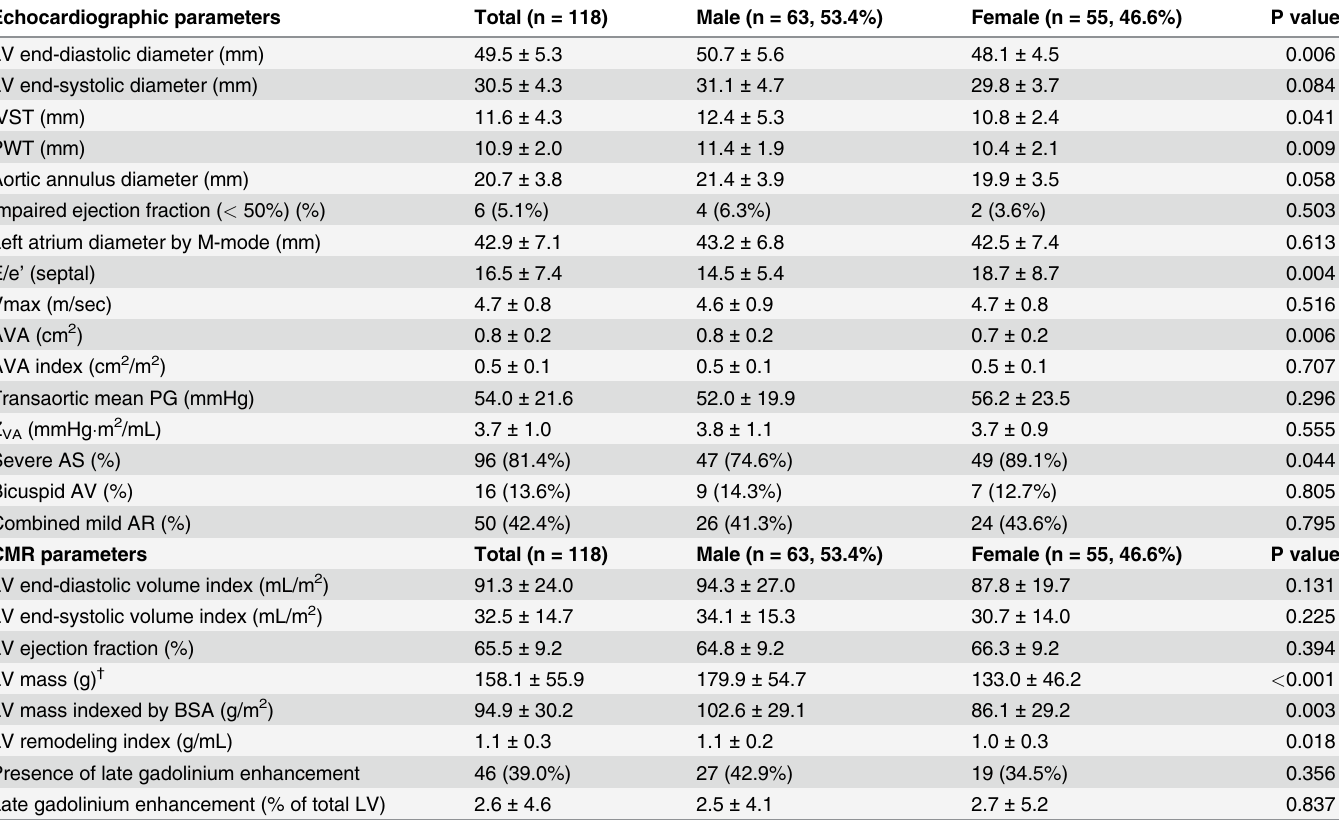
Table 2. Echocardiographic and cardiovascular magnetic resonance (CMR) parameters of the study participants. Echocardiographic